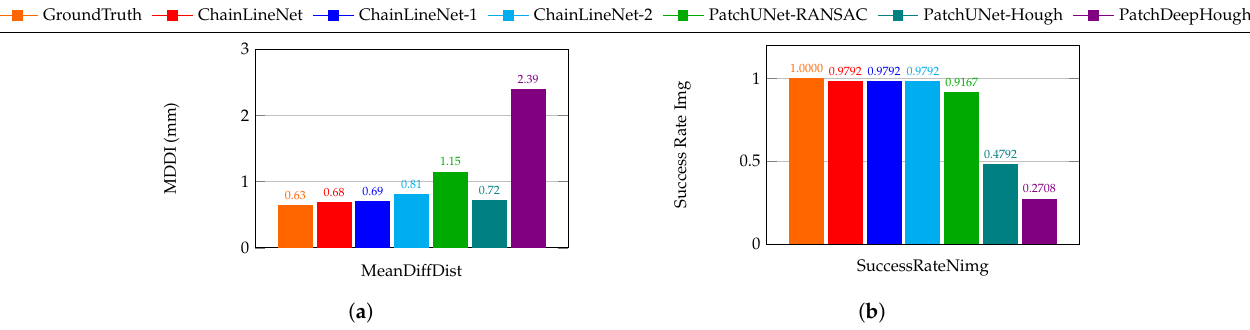
Figure 8. Comparison of ( a ) the mean difference of distance intervals (MDDI) between the predicted distances and the reference distances (manually measured by an art technologist) and ( b ) the success rate of images for which the distance intervals were compared. Our ChainLineNet (complete task loss) is compared to the end-to-end training with the task losses BCE+DICE+DSAC (ChainLineNet-1), to the training using only the segmentation task losses BCE+DICE (ChainLineNet-2), to the competing methods, and to the ground truth on the test set.